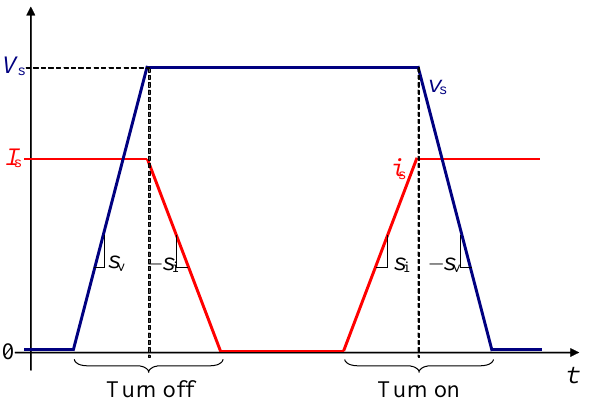
Figure 3. Assumed MOSFET voltage v s (blue) and current i s (red) waveforms in the switching transitions of power devices concentrating the switching losses.